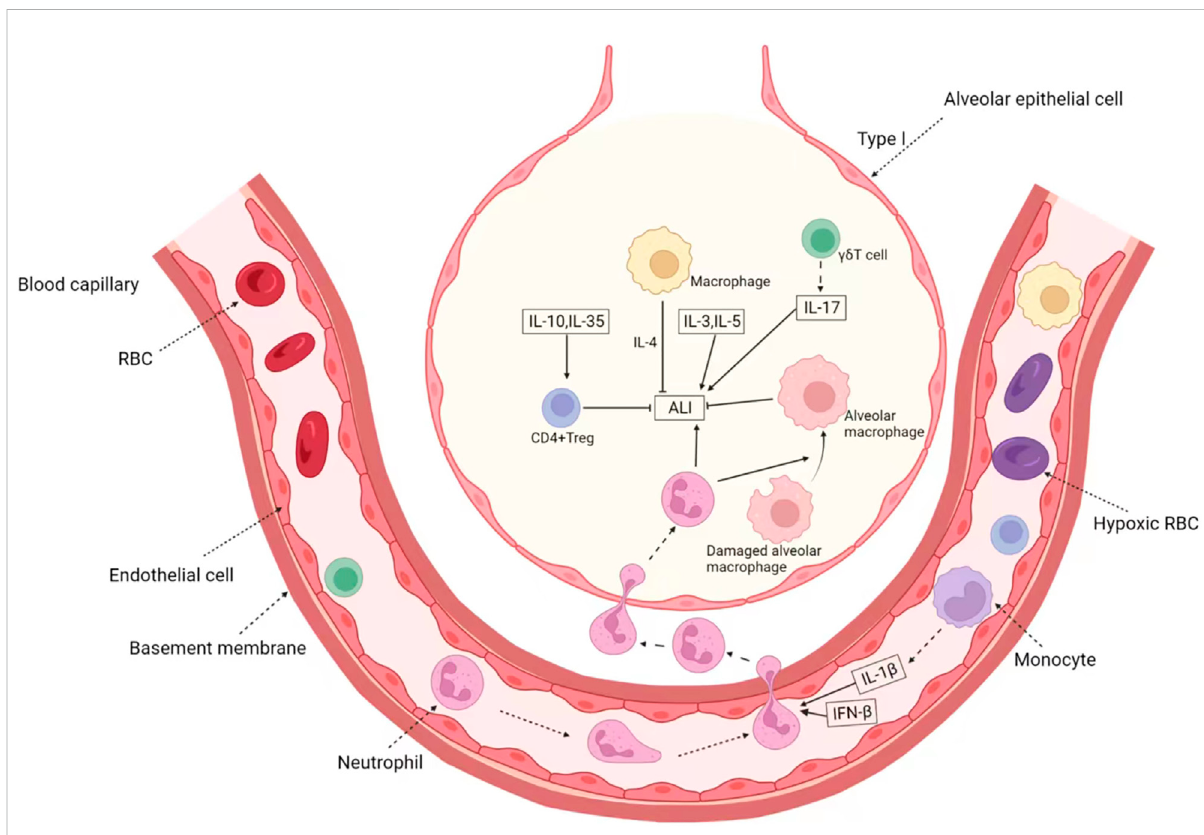
FIGURE 2 The Immune-related factors in ALI/ARDS. In ALI, immune cytokines mainly play the role of cell communication, which is represented by interleukin. Anti-in fl ammatory cytokines IL-10 and IL-35 can induce the activation of CD4 + Treg and then inhibit ALI. IL-1 β produced by monocyte and IFN- β can induce the activation of neutrophil, which aggravate ALI. Besides the factors secreted by recruited immune cell, IL-3 and IL-5 can directly promote ALI. On the other hand, activated γδ T cells and macrophages can secrete IL-17, IL-5 and so on, forming positive feedback. In addition, immune cells represented by M2-type macrophages can also secrete IL-4 to alleviate the progression of in fl